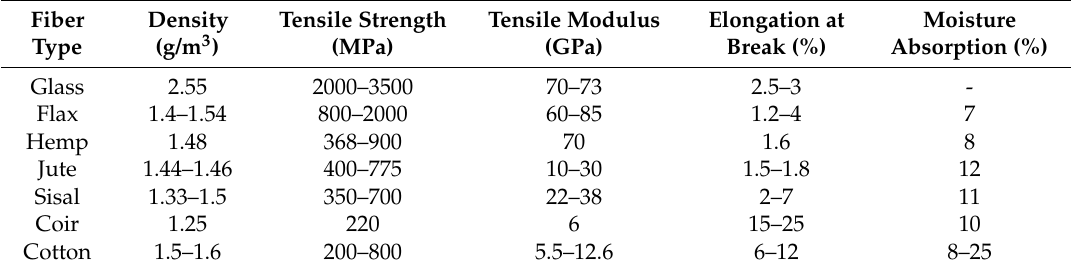
Table 1. Comparison of glass fiber with some natural fiber properties